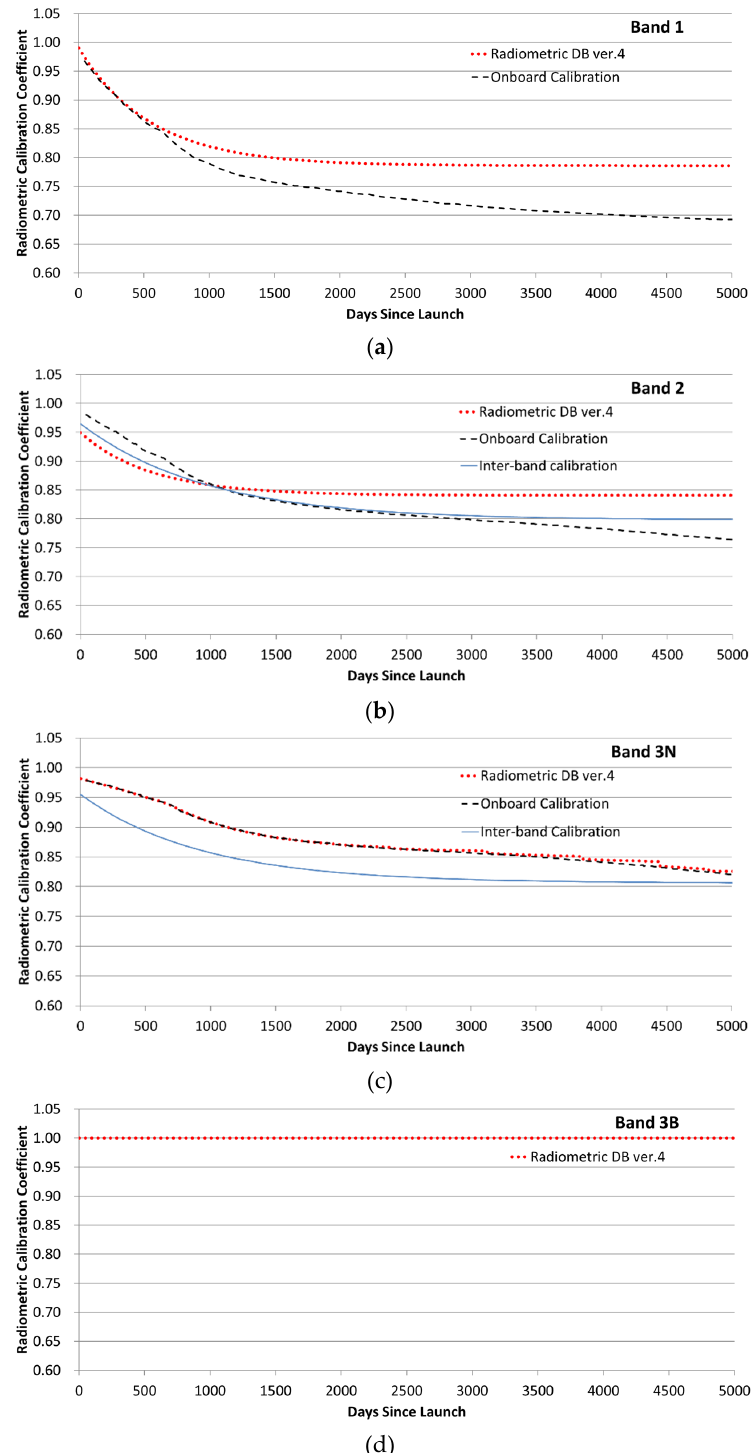
Figure 2. Degradation curves of ASTER VNIR bands in the current radiometric DB ver. 4. Bands ( a ) 1, ( b ) 2, ( c ) 3N, and ( d ) 3B. Dotted lines correspond to the current degradation curve in the current radiometric DB estimated from the results of three calibration approaches (i.e., onboard, vicarious, and cross calibrations) from 2000 to 2012. Dashed lines indicate the degradation curves derived from the onboard calibration, which is almost the same as that in the radiometric DB ver. 3. The solid lines indicate the degradation curves estimated from the inter-band calibration for ASTER VNIR Bands 2 and 3N.